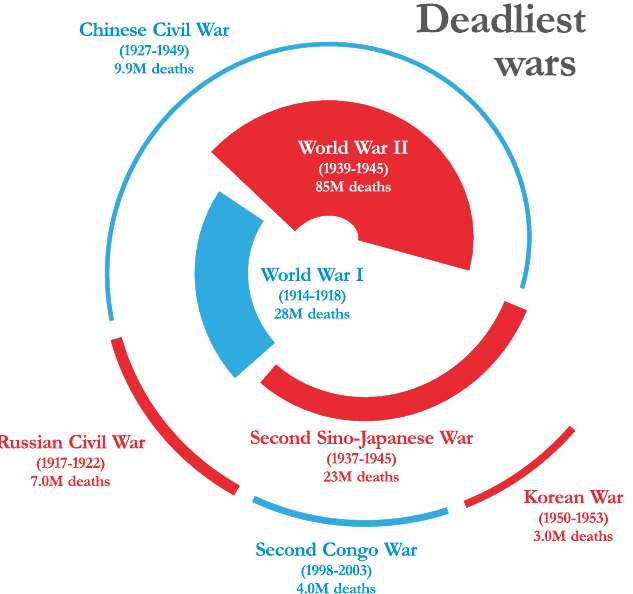
Figure 4. Seven deadliest wars in human history. The length of each spiral segment is proportional to the war’s duration, and its area size to its death toll. The death toll is expressed in millions (e.g., 9.9 M represents 9.9